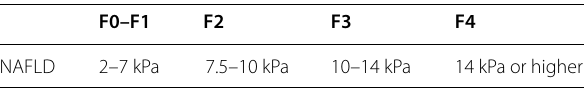
Table 1 Grading of fibrosis in NAFLD patients according to FibroScan